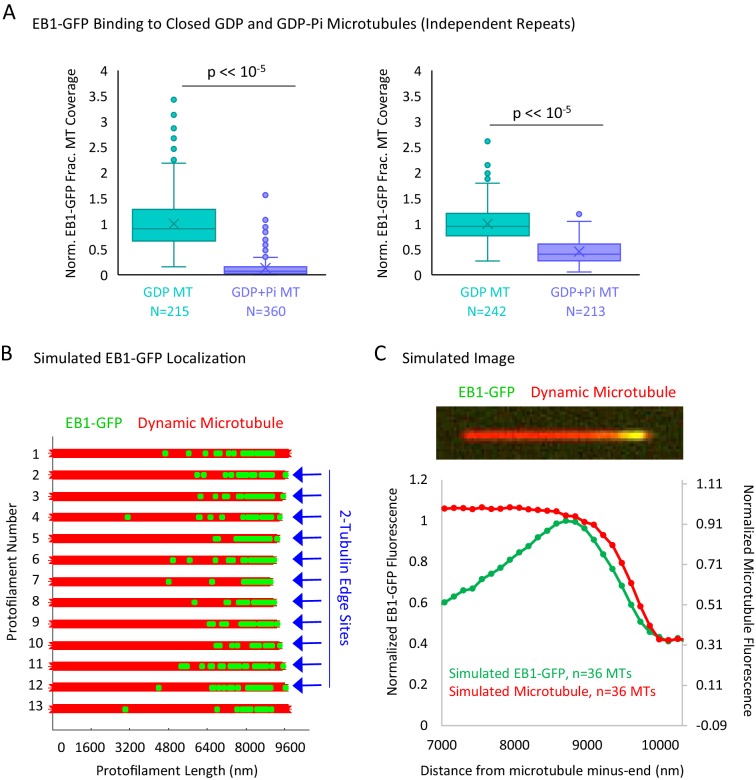
Additional Data to Support Figure 5.(A) Experimental repeats to evaluate the binding of EB1 to closed GDP and GDP+Pi microtubules. Each plot represents a different experimental day. (B) Graphical representation of a flattened microtubule, showing microtubule protofilaments (red) with EB1-GFP at the microtubule plus-end (green). The microtubule shown has moderate taper at its plus-end (at the right of schematic). EB1-GFP is localized at the microtubule plus-end via two rules: (1) the EB1-GFP is distribution decreases exponentially away from the tip, starting at the first complete layer of tubulin subunits, and (2) the 2-tubulin ‘protofilament edge’ sites are fully occupied by EB1-GFP. Locations with 2-tubulin edge sites are noted with blue arrows. The longest two protofilaments (1 and 13) are not assigned edge sites to account for a closed tube. (C) Top: Simulated image of a microtubule (red) with EB1-GFP at its end (green). Bottom: Super-averaged line scan data from 36 simulated microtubules with varying degrees of tip taper. Similar to previous reports (Maurer et al., 2014), the peak in EB1-GFP appears to be slightly penultimate to the microtubule end, suggesting that binding to protofilament edges may not significantly bias the observed EB1-GFP fluorescence distribution at the microtubule plus-end.